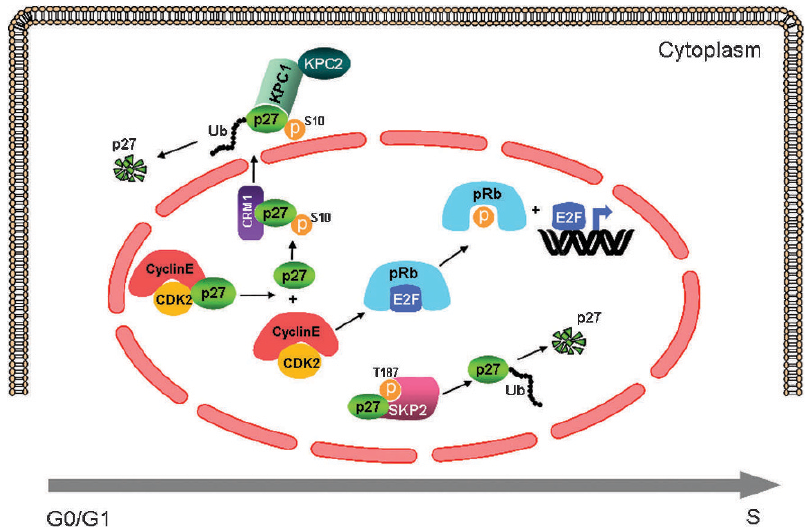
Figure 3 - Graphic representation of the nuclear and cytoplasmic interactions of p27. Upon mitogenic stimulation, p27 is released from cyclinE/CDK2 complexes and this dissociation from p27 activates CDK2, which, in turn, phosphorylates pRb. Phosphorylated pRb releases the transcription factor E2F, which induces the expression of genes required for the G1 to S progression. After the dissociation of p27 from the cyclinE/CDK2 complex in early G1 a portion of p27 is phosphorylated on Ser10 and exported into the cytoplasm through the interaction with CRM1 (exportin). Once in the cytoplasm, p27 is ubiquitylated by the KPC1/KPC2 complex and degraded by the proteasome. Upon mitogenic stimulation p27 becomes the substrate of the cyclinE/CDK2 complex, which phosphorylates the protein at the Thr187 residue, thereby creating a recognition site for the SKP2 ligase, which promotes ubiquitylation-mediated degradation of p27 by the proteasome in S